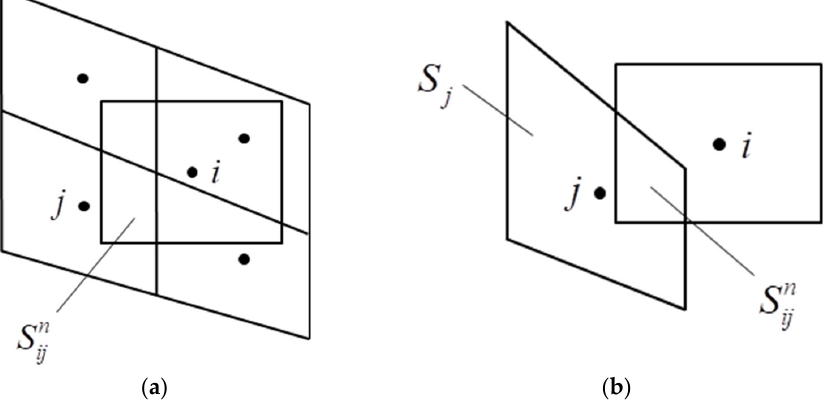
Figure 2. Diagram illustrating the determination of gas characteristics in a particle cell grid: ( a ) the gas parameters in the i ‐ th particle cell; ( b ) the particle parameters in the j ‐ th Eulerian gas cell.